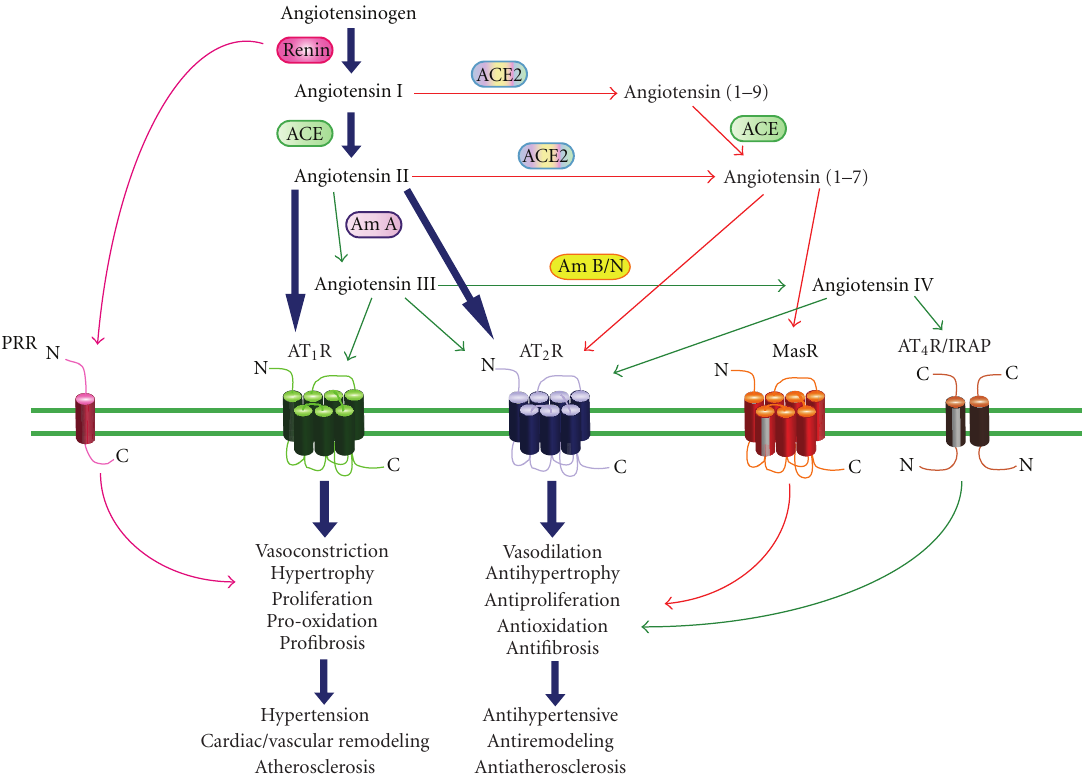
Figure 1: Summary of the RAS incorporating the Ang peptide family and physiological e ff ects mediated via ATR subtypes. Under the classical RAS schema, Ang II is produced, via renin and ACE, to act with equal a ffi nity on two ATR subtypes, AT 1 R and AT 2 R (large arrows). However, it is now appreciated that a number of breakdown products of Ang II, namely, Ang (1–7), Ang III, and Ang IV exert their own unique e ff ects that are distinct (and often opposite) to those of Ang II. Such e ff ects are often mediated via newly recognized receptors such as MasR for Ang (1–7) and AT 4 R (also known as IRAP) for Ang IV, or additionally via AT 2 R stimulation. ACE2 is also a new pathway for the formation of Ang (1–7). Newly identified Ang receptor binding proteins associated with di ff erent ATR subtypes may also modify ATR activation. Thus, overstimulation of AT 1 R (and PRR) by Ang II, which can contribute to a plethora of cardiovascular disease processes, may be counter-regulated by a number of non-AT 1 R mechanisms. Most notably, AT 2 R stimulation usually causes opposing e ff ects to AT 1 R, as indicated. It is also likely that the MasR exerts a similar counter-regulatory role whereas the evidence is more preliminary and speculative for AT 4 R/IRAP. In terms of mediators, Ang II itself stimulates AT 2 R whereas the shorter Ang peptides stimulate their cognate receptors and possibly also AT 2